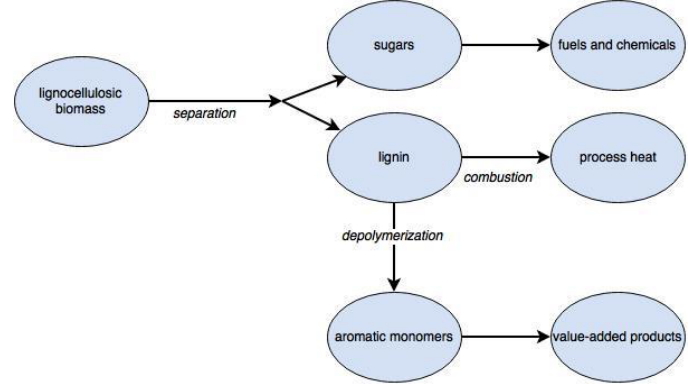
Figure 1. The lignin polymer can be processed via combustion, chemical processing, thermochemical processing, biological processing or a combination of these routes. This review covers chemical, thermochemical, and biological processing of depolymerized lignin to produce industrially relevant chemicals.